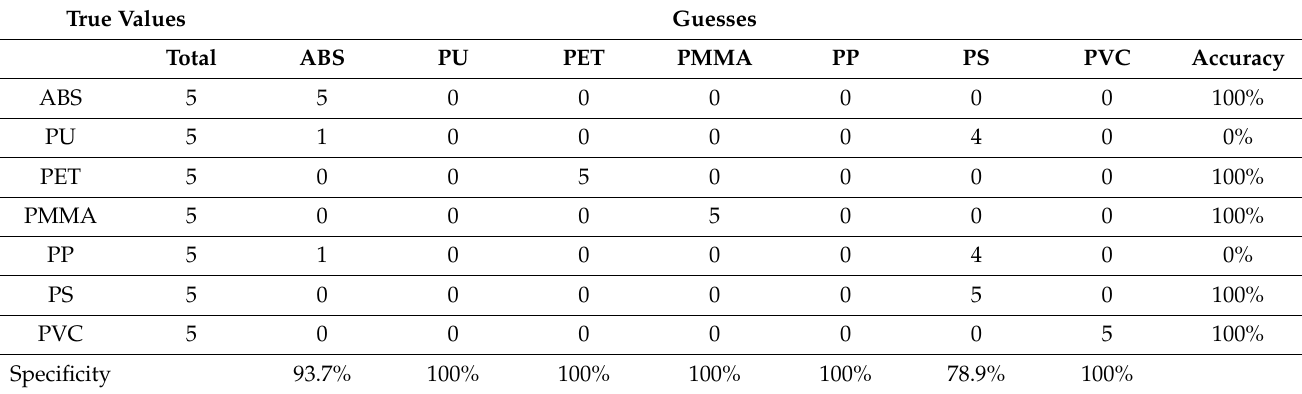
Table 2. Confusion matrix of the test data with calculated accuracy (sensitivity) and specificity of each material, when pulse salvo classification is